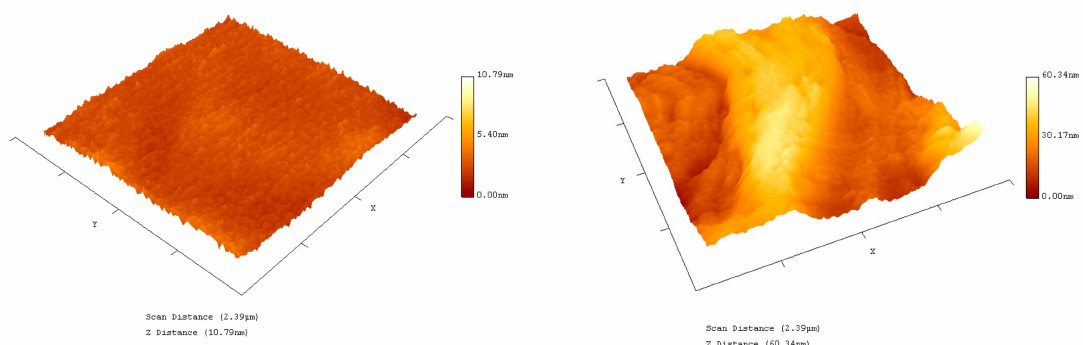
Figure 6. Atomic Force Microscopy (AFM) image of bare graphene on Si/SiO 2 ( left ) and functionalised with Pyr-NHS linker, Ab, BSA and the corresponding hCG antigen ( right ).